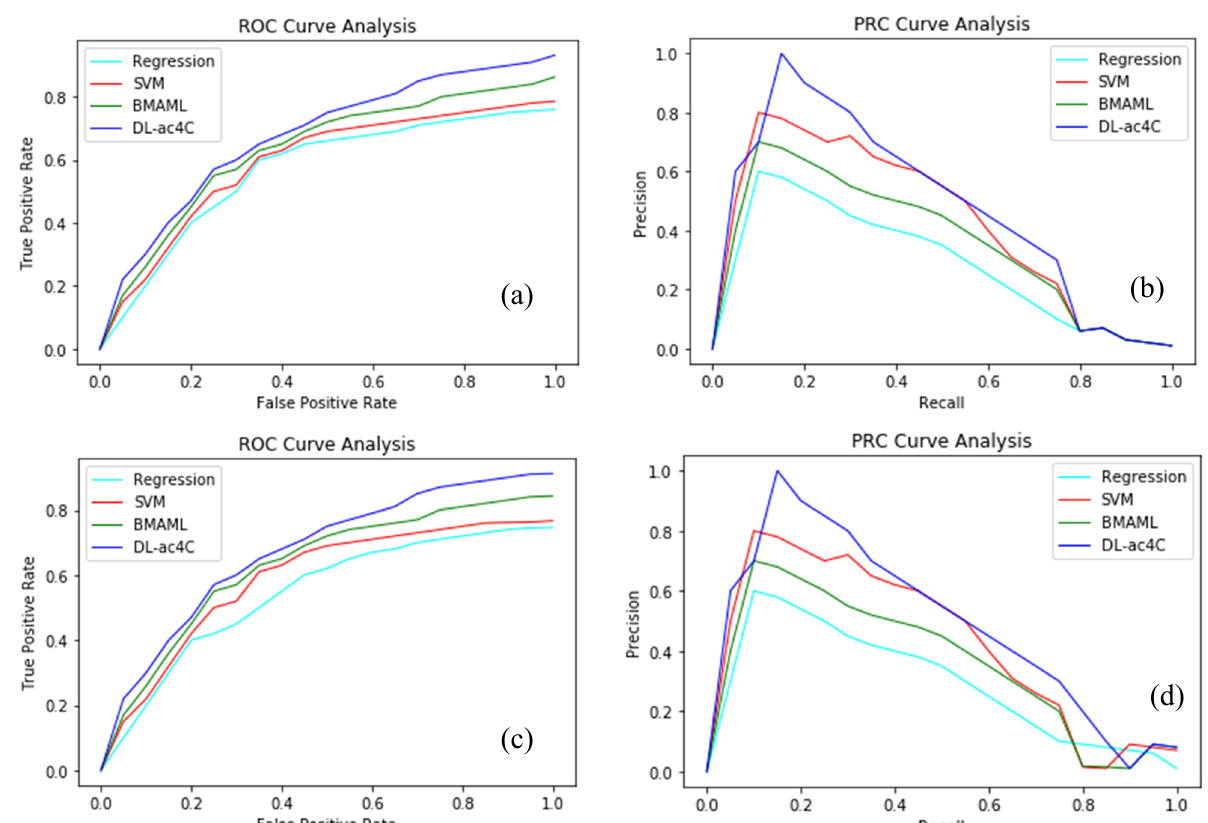
Figure 3. Graph ( a ) for cross validation test ROC, and graph ( b ) for cross validation test of PCR and graph ( c ) for independent test for ROC and graph ( d ) independent test of PRC.